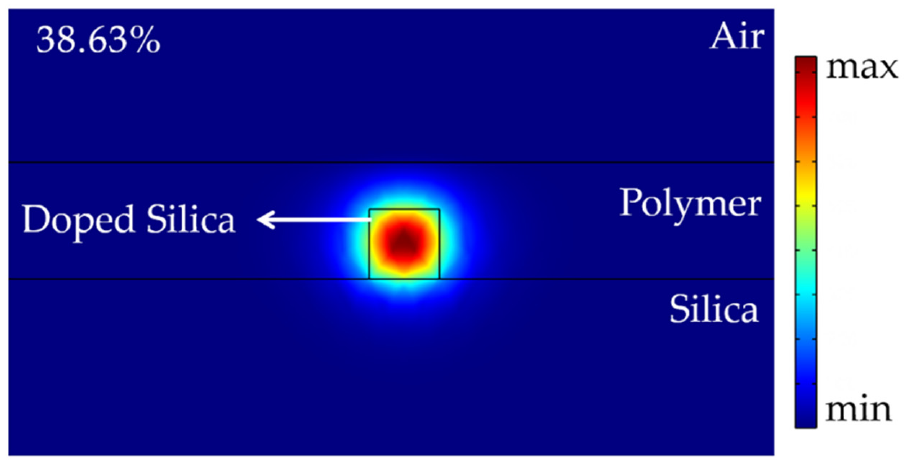
Figure 4. Optical field distribution of the heating arm ( a ) when the width-to-height ratio of the core is 1:3 and ( b ) when the width-to-height ratio of the core is 1:2.